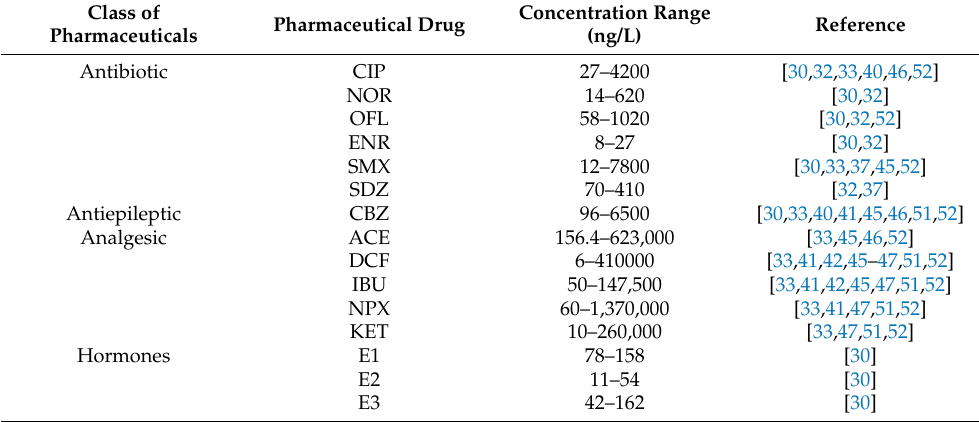
Table 2. Concentration ranges of pharmaceuticals present in the influent of municipal WWTPs.